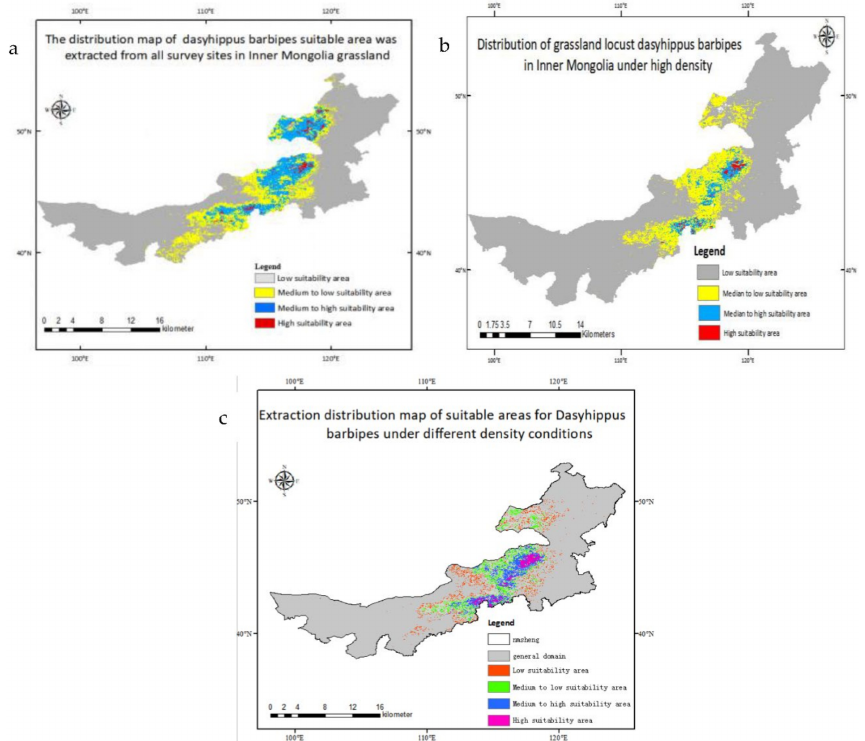
Figure 6. The distribution maps of the dominant species dasyhippus barbipes, based on our maximum entropy model under three scenarios: ( a ) the extract results using all survey points; ( b ) the results using the high-density (more than 15 locusts/m 2 ) survey points; ( c ) the density stratification